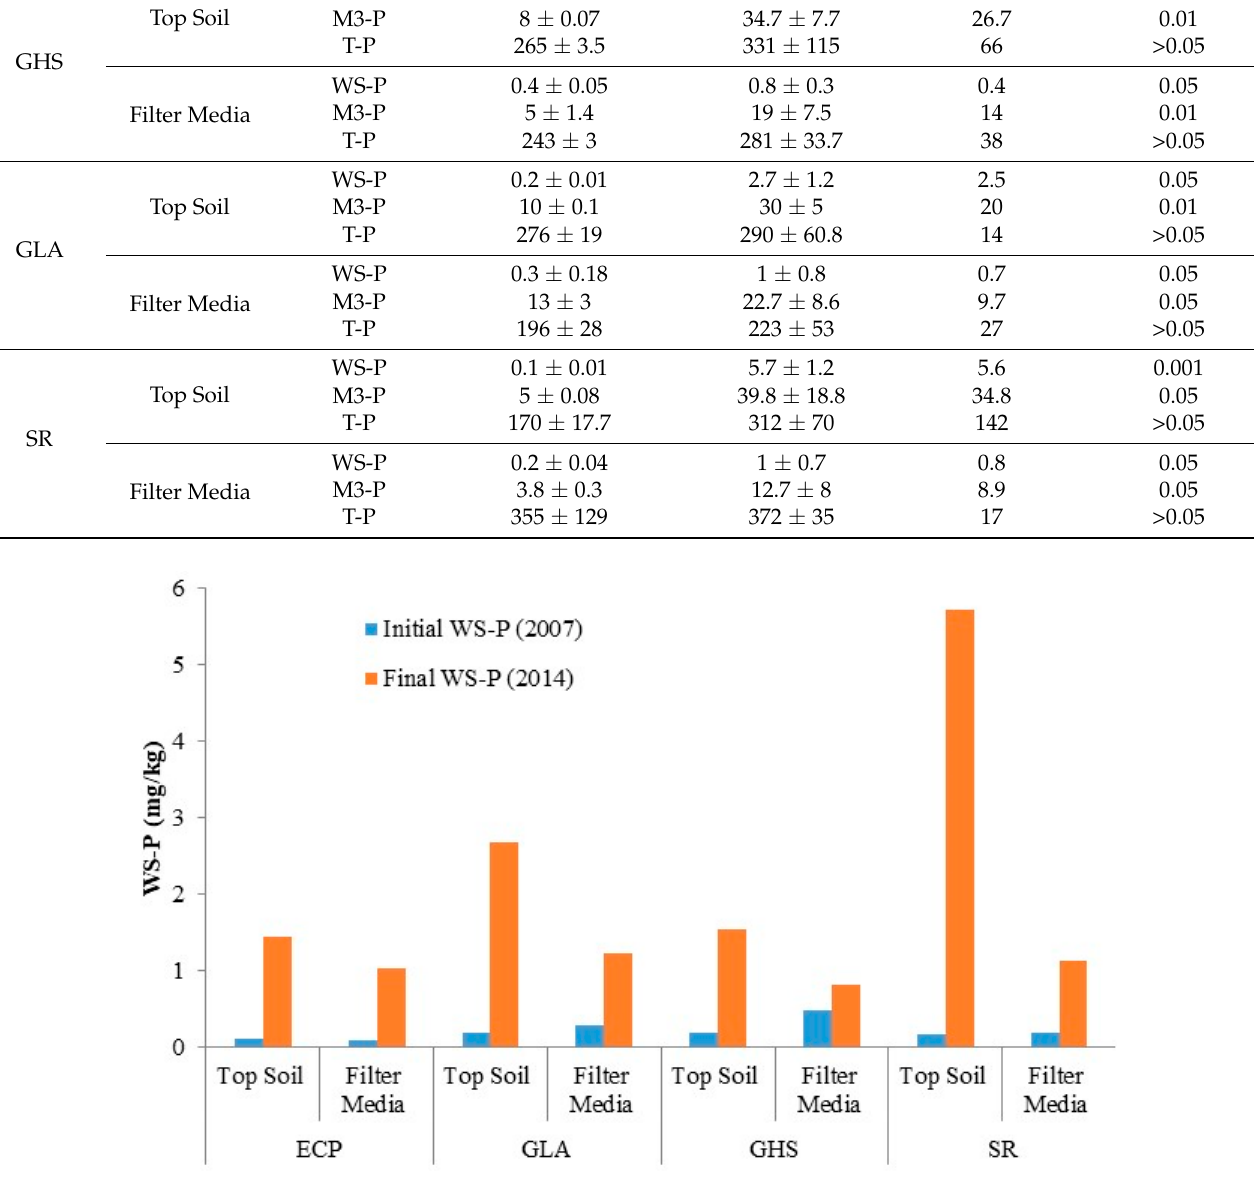
Figure 11. M3-P mass concentrations in top soil and filter media in 2007 and 2014.